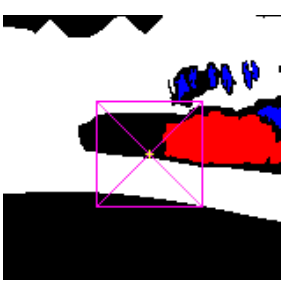
Figure 5. Example of window (in magenta) centered over an undefined black